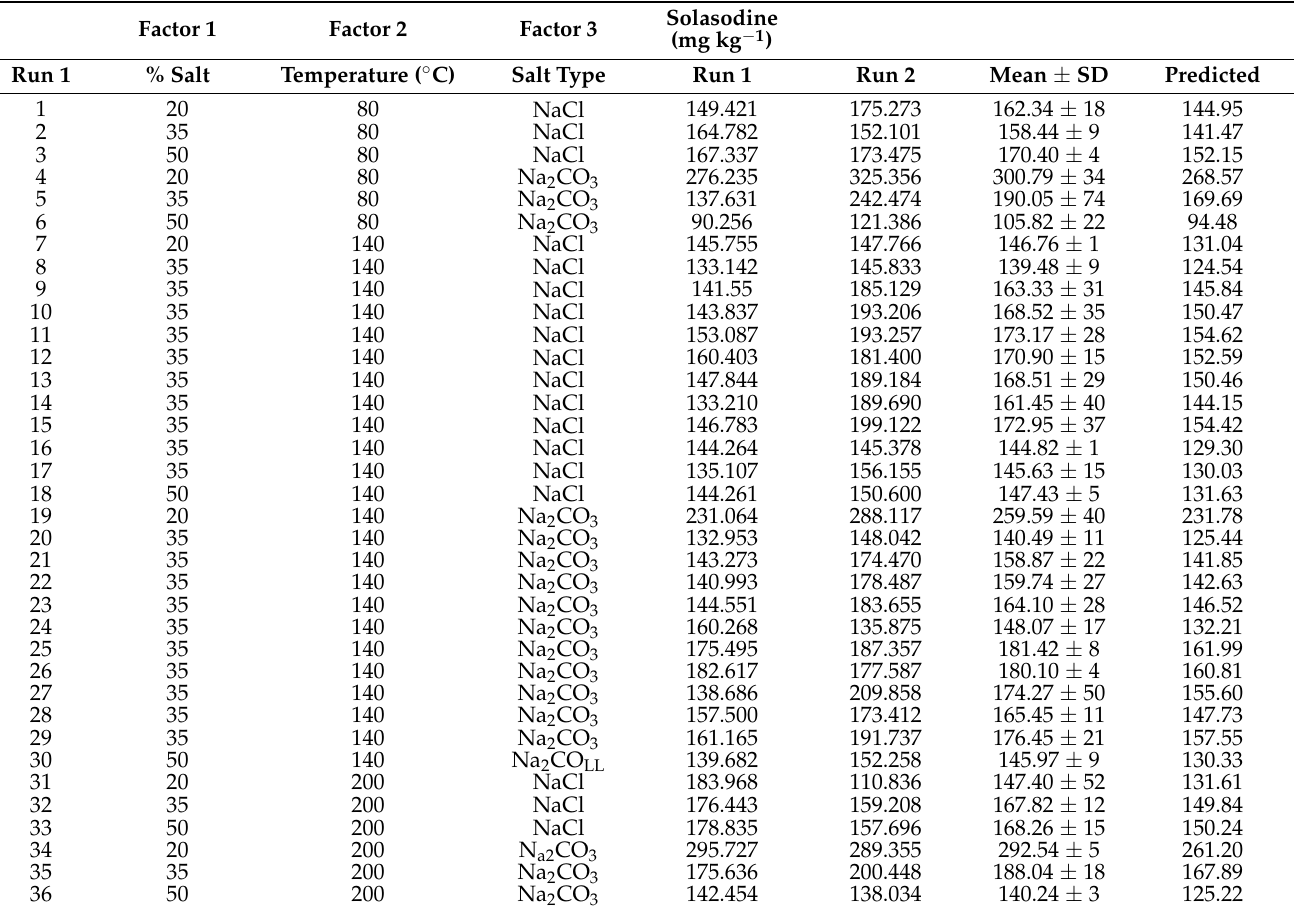
Table 1. Experiments designed by CCD for ATPE optimization with the respective responses and predicted